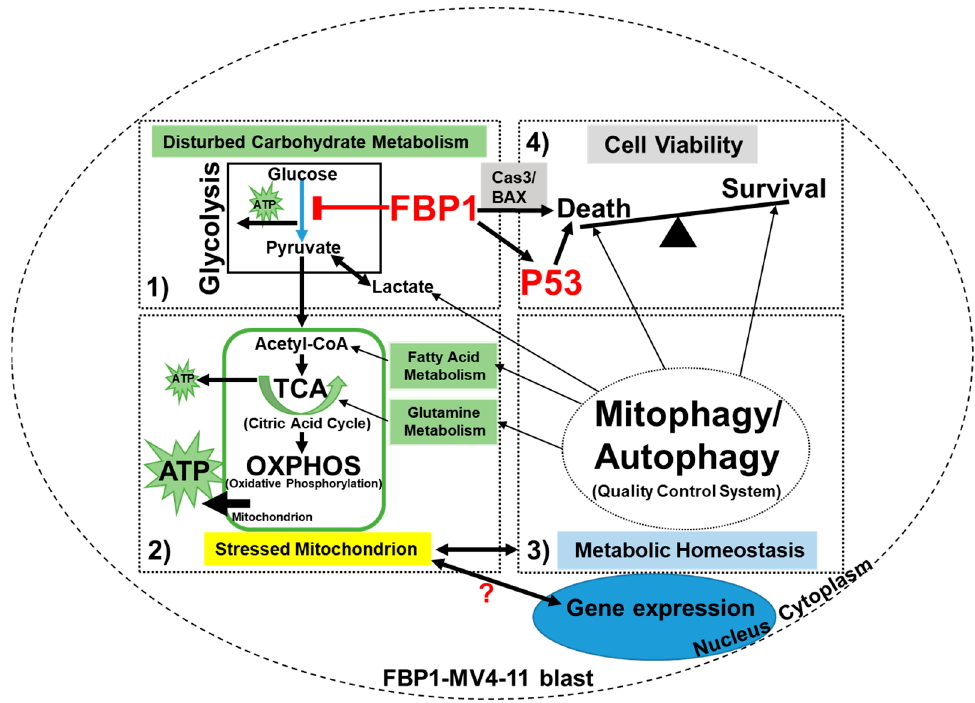
Figure 5. A schematic diagram of the anti-leukemic functional roles of FBP1 and FBP-activated P53 in AML blasts in vitro: There are multifaceted anti-leukemic functions of FBP1 in the treatment of AML blasts; FBP1 inhibits the process of glycolysis by reducing key intermediate metabolites such as pyruvate ( BOX1 ) and regulates blast differentiation via changes in cellular signaling. FBP1-disturbed glycolysis can induce stress in the mitochondria ( BOX2 ), leading to the reduction in COX2 in the OXPHOS process. To maintain metabolic homeostasis and survive, FBP1-MV4-11 blasts can activate the quality control system of mitochondria via upregulation of PINK1 ( BOX3 ). The activated mitophagy and autophagy can replenish key metabolites such as fatty acids and glutamine, to either promote the regeneration of dysfunctional mitochondria ( BOX3 ) or prevent cell death ( BOX4 ). In addition to its glycolytic regulatory function, FBP1 can increase pro-apoptotic proteins and tumor suppressors—such as caspase-3, BAX, and P53—while decreasing hypoxic oncogenes such as HIF1A (not shown), leading to programmed leukemic cell death ( BOX4